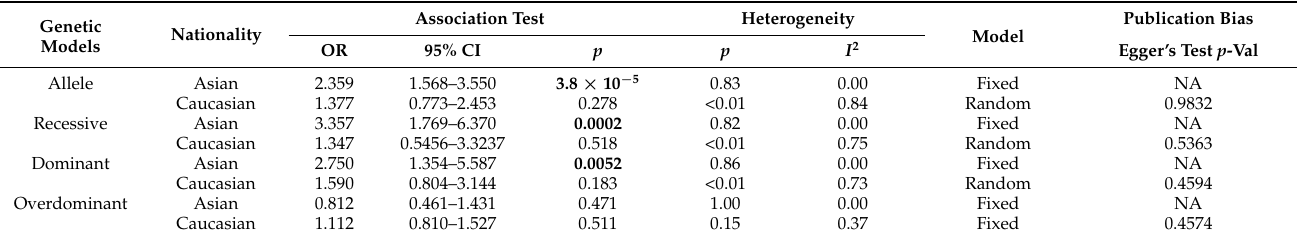
Table 3. Subgroup analysis between HLA-G polymorphism (14-bp insertion/deletion (rs16375)) and susceptibility to acute rejection in kidney transplant recipients according to nationality. Genetic